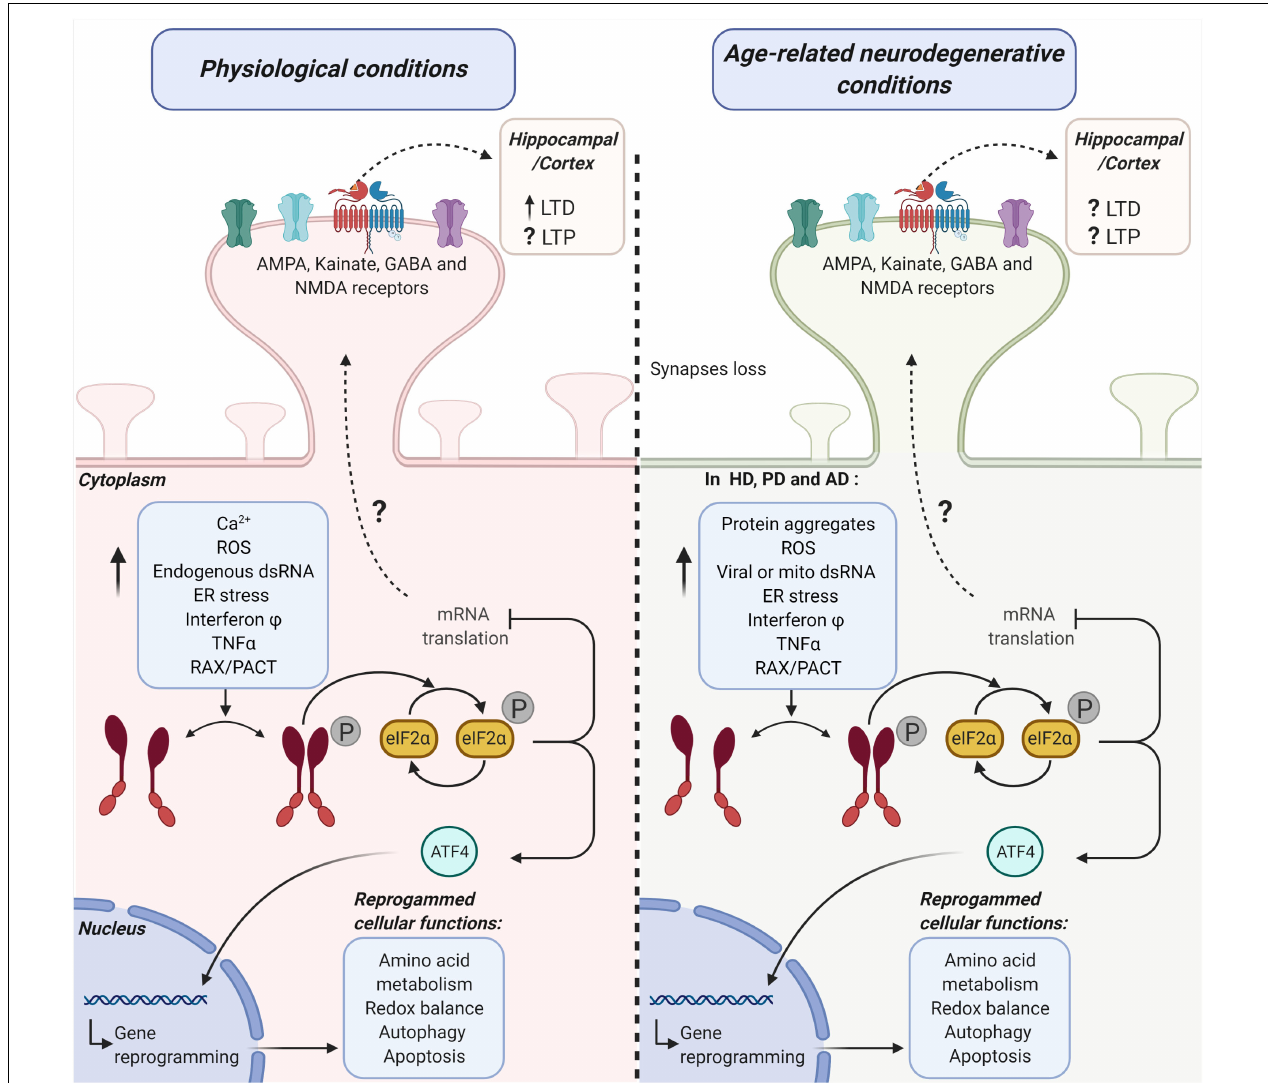
FIGURE 1 | Possible mechanistic links between the activation of the PKR-eIF2 α branch of the ISR and hippocampal/cortical plasticity under physiological and age-related neurodegenerative conditions. The diagram represents the potential role of the double-stranded RNA protein kinase [protein kinase R (PKR)] in synaptic transmission efficiency under physiological conditions (left side) and age-related neurodegenerative conditions (right side). PKR-activating stimuli induce a significant increase in the phosphorylation (P) of the alpha subunit eukaryotic initiation factor 2 (eIF2 α ) in a dsRNA-dependent manner or via its endogenous activator RAX/PACT. This pathway activation promotes the inhibition of mRNA translation and ATF4 dependent gene reprogramming of several cellular functions. Altogether, PKR-eIF2 α ISR branch activation may lead to cell adaptation or cell death. PKR-eIF2 α ISR branch loss of function (LOF) under physiological conditions (left side) significantly modifies cortical and hippocampal receptor-mediated synaptic transmission. Consequently, long-term potentiation (LTP) and long-term depression (LTD) are also affected. Under age-related neurodegenerative conditions (right side), common stimuli could participate in the activation of PKR-eIF2 α ISR branch activation in Huntington’s diseases (HD), Parkinson’s disease (PD), and Alzheimer’s disease (AD). Under this activation, ATF4 translocates to the nucleus and mediates degenerative reprogrammation. On the other hand, the eIF2 α phosphorylation decreases mRNA translation. This decrease in translation induces modifications in the hippocampal and cortex LTP and LTD through an unknown